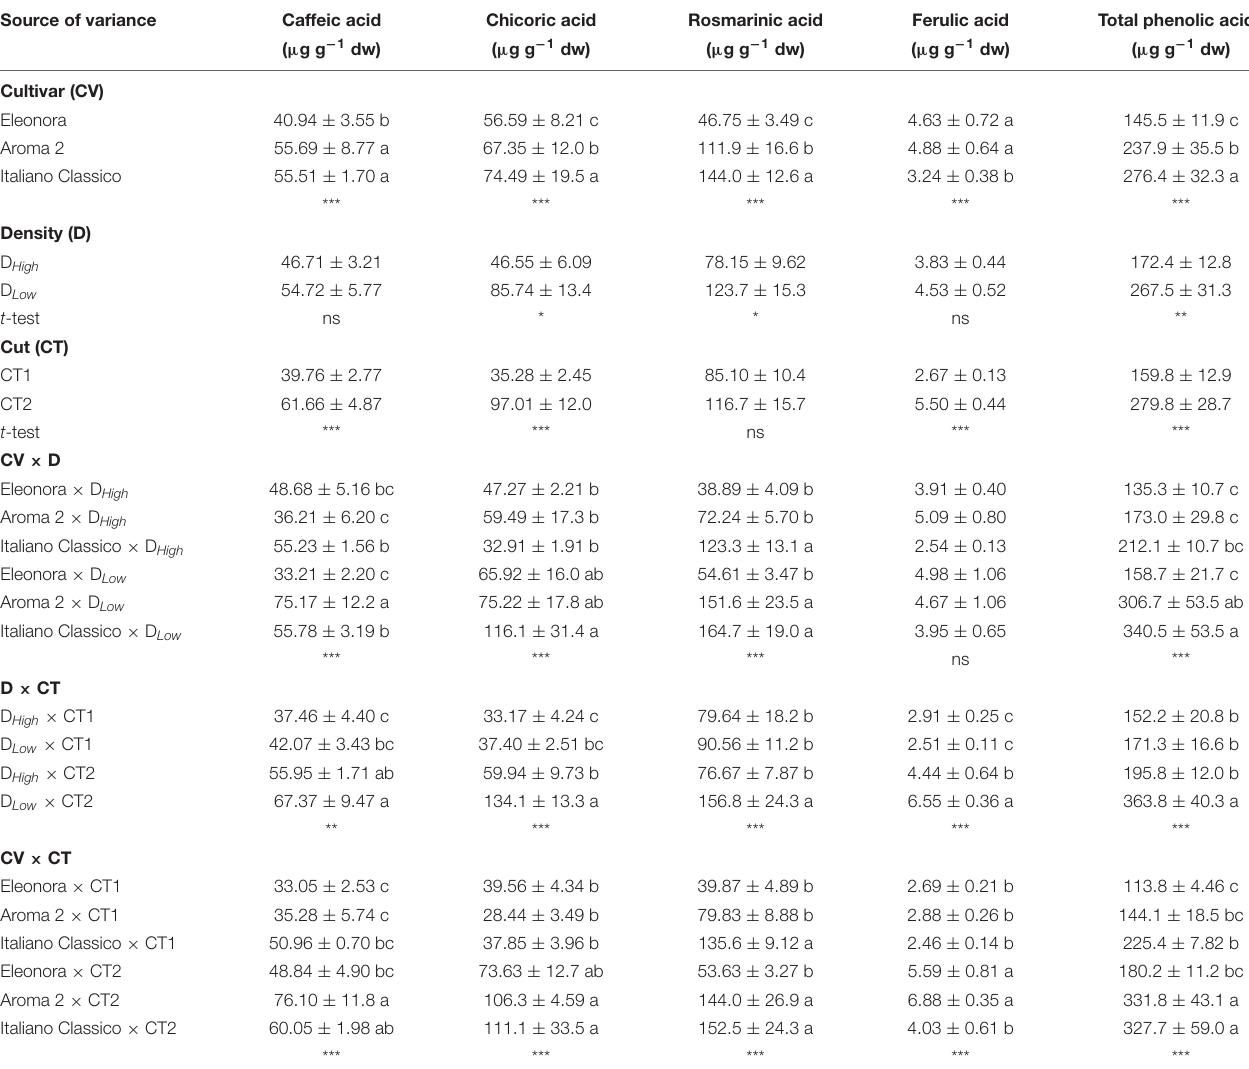
TABLE 5 | Phenolic acids and total polyphenols of Genovese basil cultivars Eleonora, Aroma 2, and Italiano Classico in light of density and cut treatments. Source of